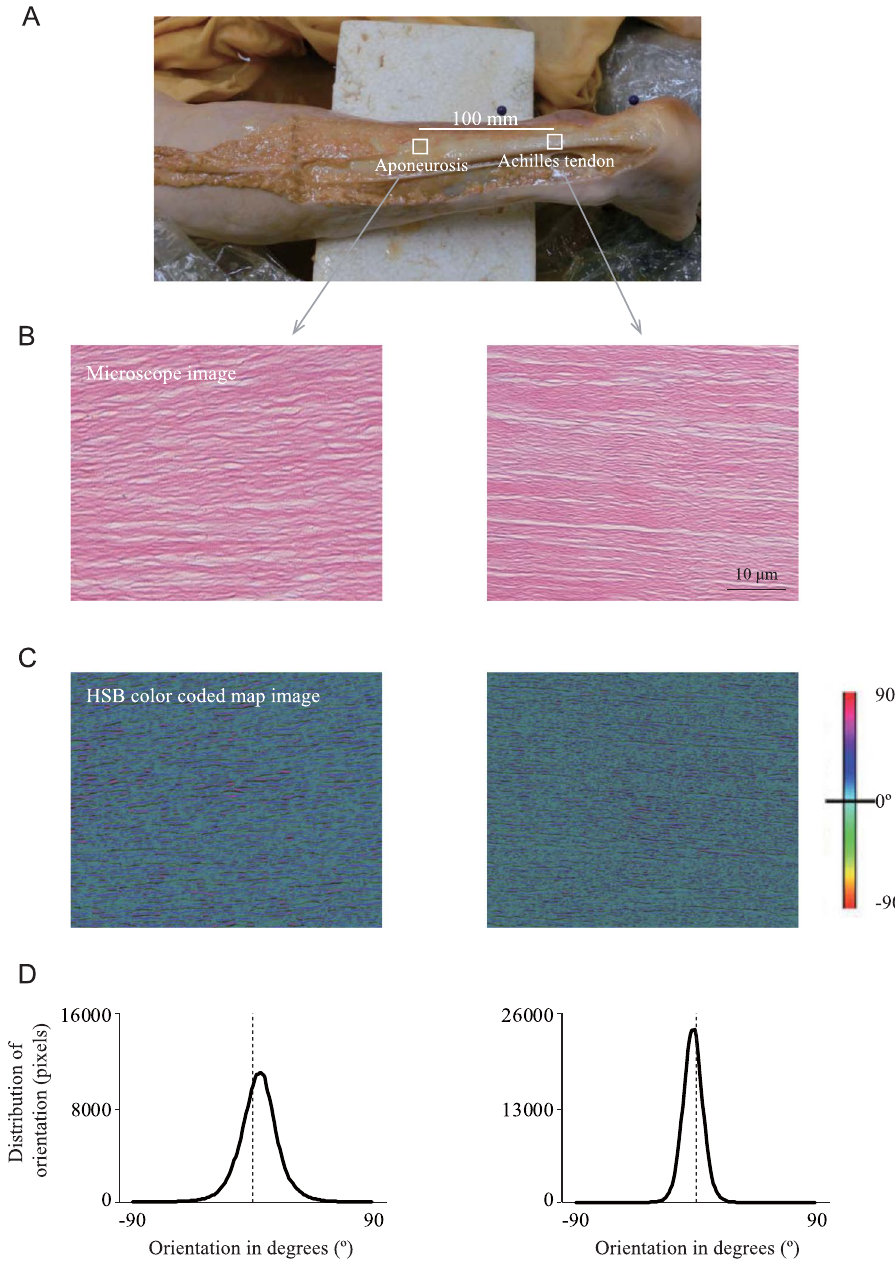
Figure 5. Collagen fiber orientation of the Achilles tendon and aponeurosis. ( A ) The Achilles tendon is exteriorized along with the proximal aponeurosis after removing the skin surface from the lower leg. ( B ) Typical longitudinal light micrograph (40 × magnification) of the Achilles tendon and aponeurosis stained with hematoxylin show the wavy appearance of the collagen fibers. The left and right images show the microscope image from the Achilles tendon and aponeurosis, respectively. The bar indicates 10 μ m. ( C ) Typical example of a hue-saturation-brightness (HSB) color-coded map, which shows the angles of the Achilles tendon and aponeurosis, respectively. ( D ) Typical orientation histogram of the collagen fibers at the Achilles tendon and aponeurosis, respectively. The orientation values in the histograms are weighted by the coherency values to give greater importance to the orientations that corresponded to elongated structures in the local neighborhood (n =